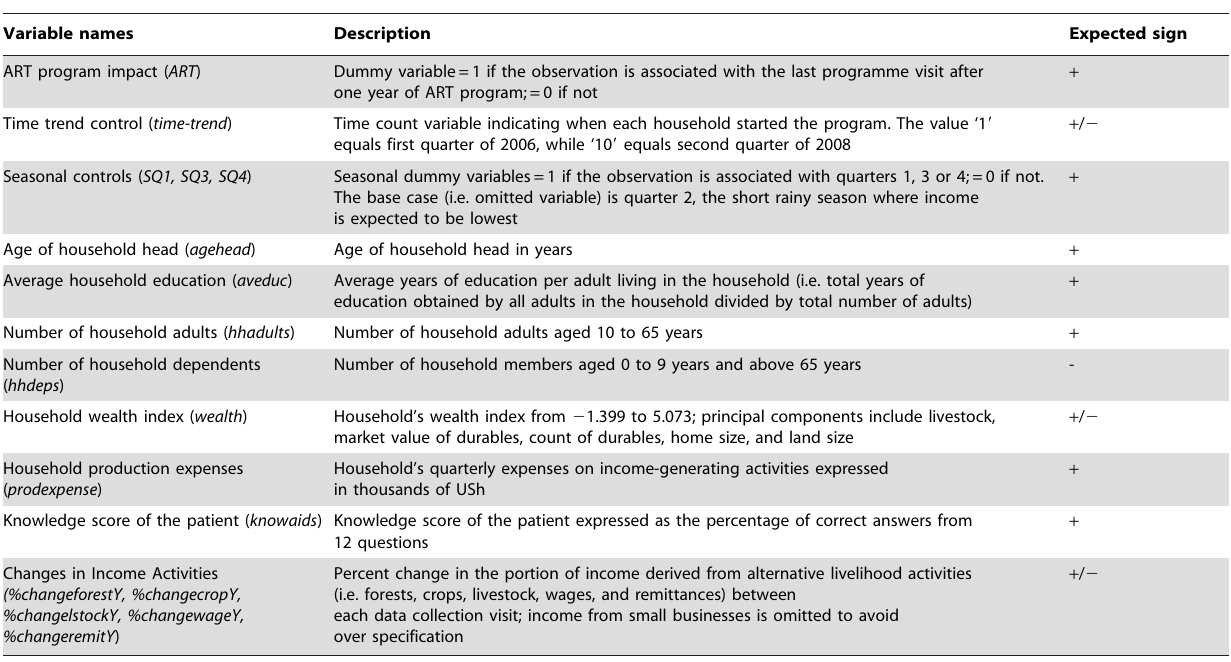
Table 1. Description of independent variables and expected